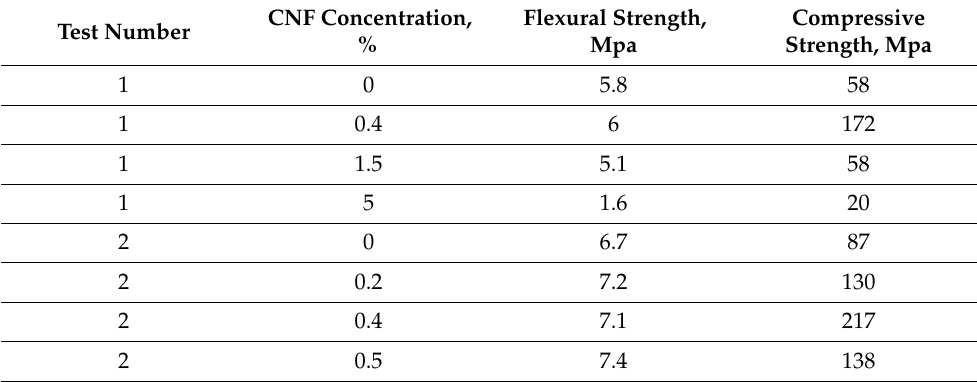
Table 5. Mechanical properties of samples of CNF/clinker composite. Reproduced with permission from [96], Elsevier, 2013. CNF